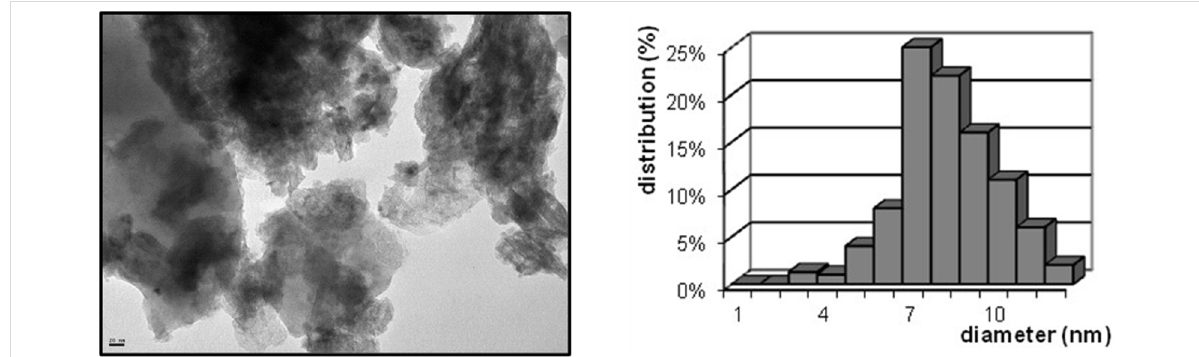
Figure 1: TEM micrograph and size distribution graphic for CoNPs@MgO catalyst (scale bar = 20 nm).